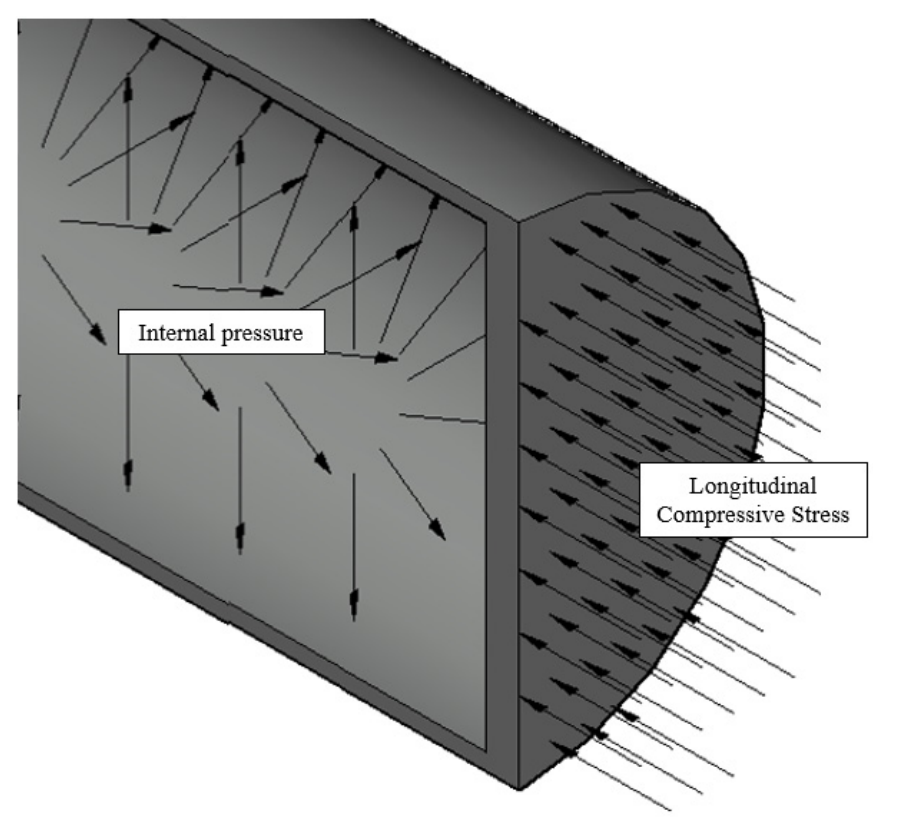
Figure 3. Loads applied on the pipe model.